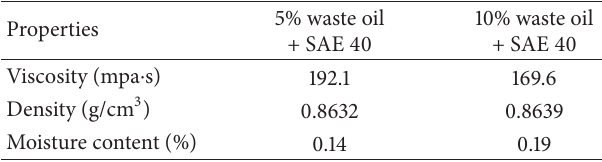
Table 5: Properties of blended volume concentration for waste